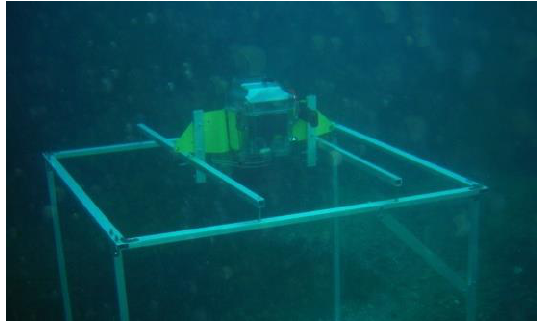
Fig. 7 - The first scanning system designed to scan at high resolution the erosion of the floor. (ISCR Archive)